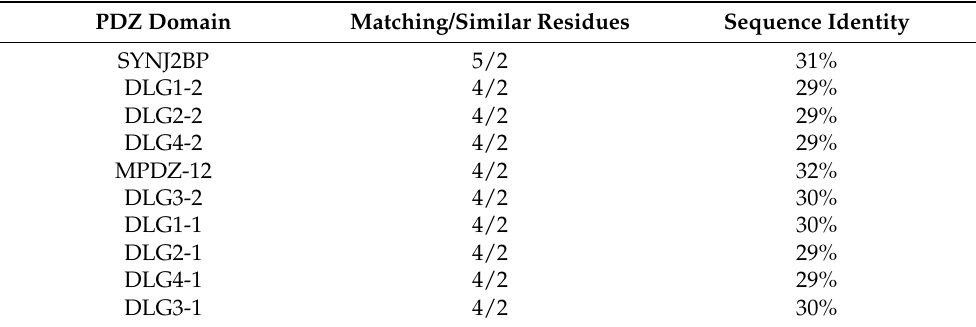
Table 2. DAMM program results for A9UPE9